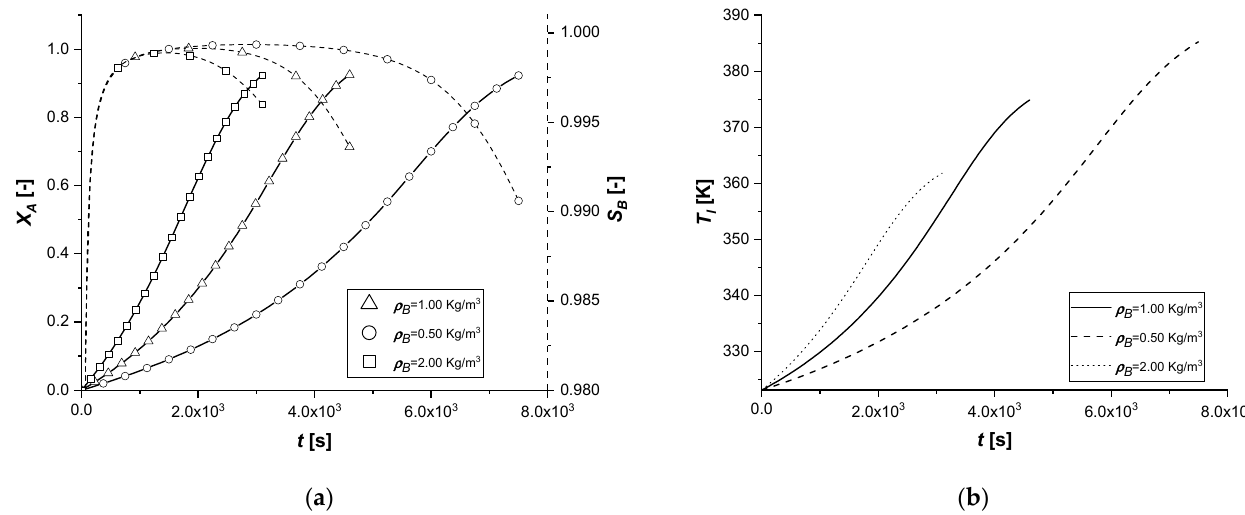
Figure 23. ES ρ P investigation. ( a ) Bulk profiles over time of X A and S B . ( b ) Bulk profile of T l over time.